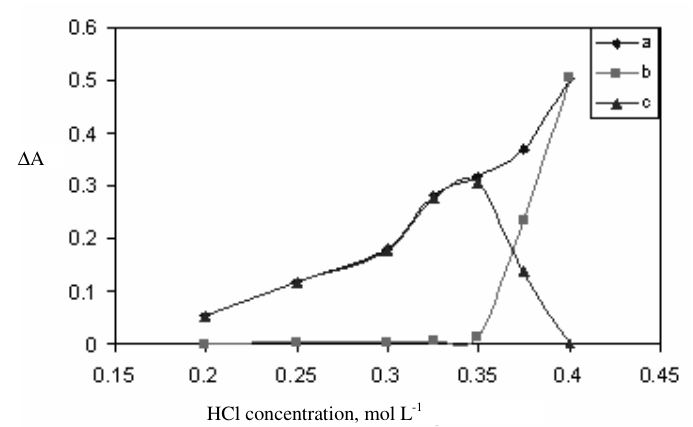
Figure 2. Absorbance change for (a) blank, (b) sample reaction and (c) their difference as a function of HCl concentration, conditions: bromate, 6.5 × 10 -4 mol L -1 ; iodide, 7.9 × 10 -5 mol L -1 ; methyl orange, 10 mg L -1 ; t = 60 s.